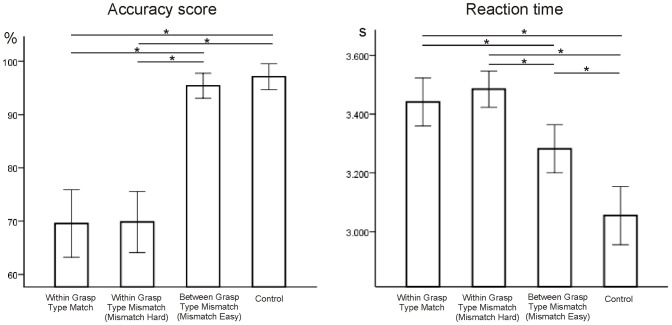
Behavioral performance.Left hand graph depicts percent accuracy scores in the four conditions. Right hand graph illustrates the conditions’ reaction times. Results of the post hoc paired-sample t-tests are indicated above the bars. * implies a p-value <.001. Error bars represent 95% confidence intervals of the mean.